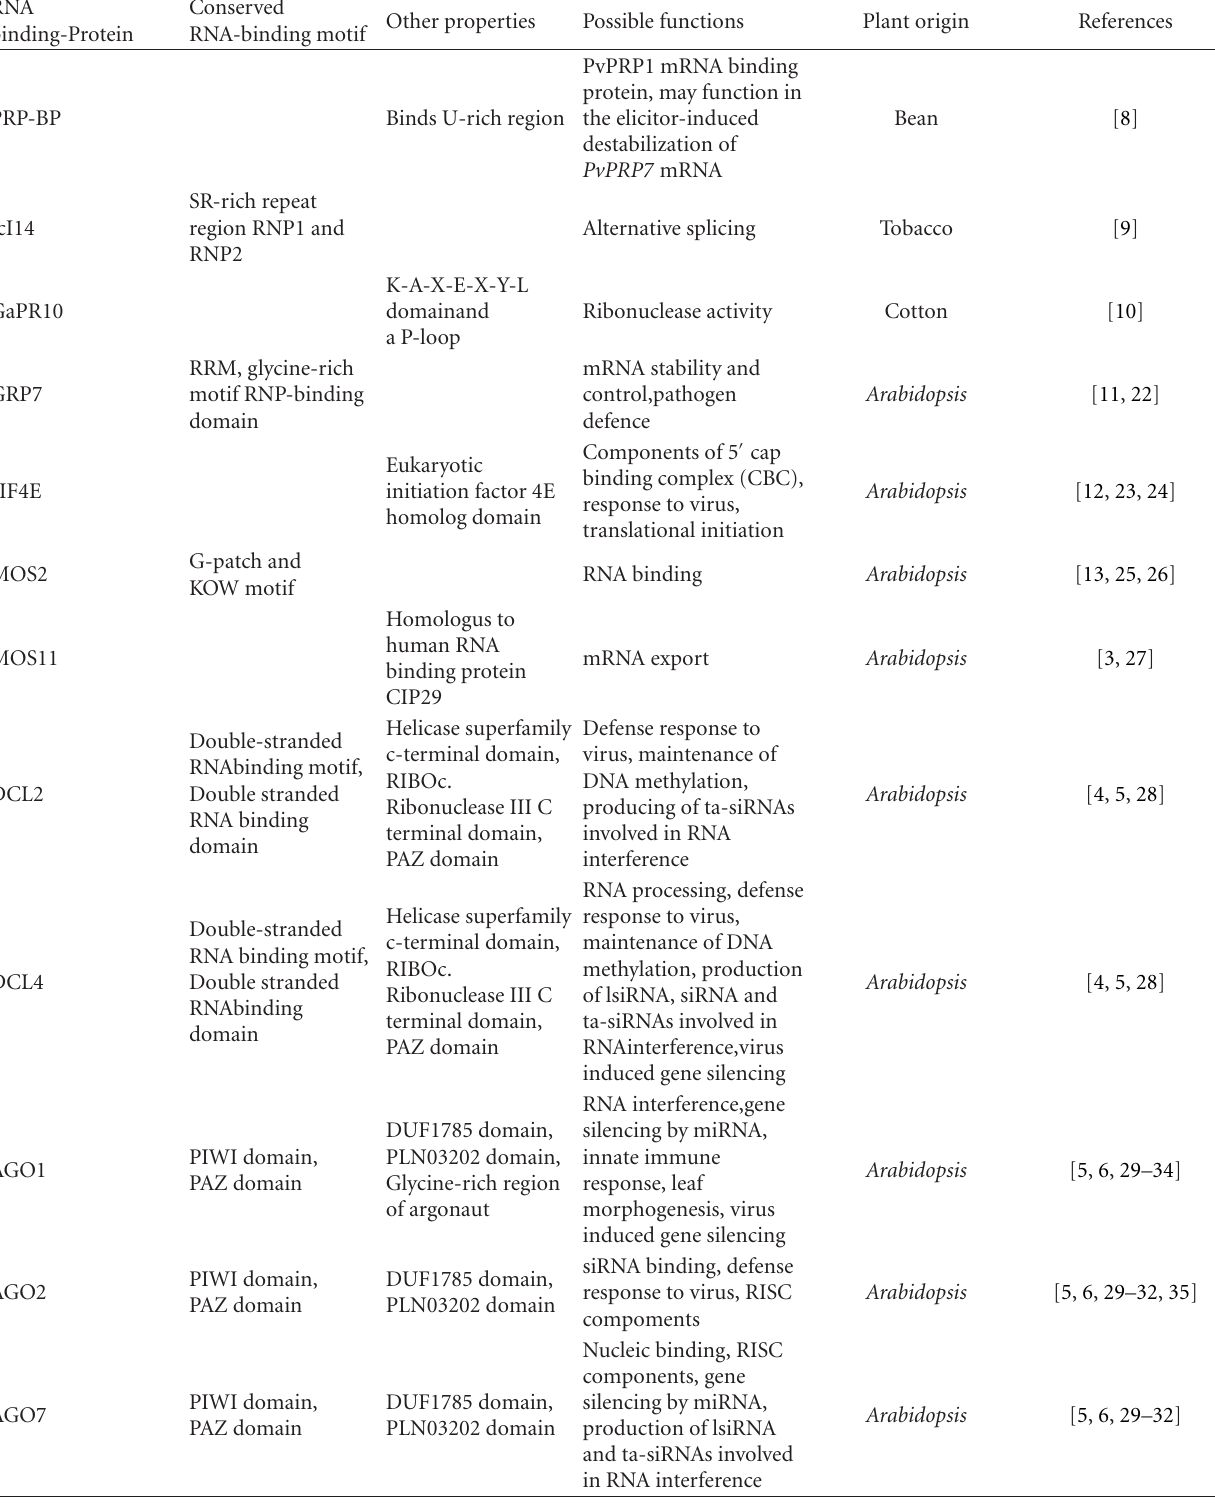
Table 1: Summary of RBPs in plant